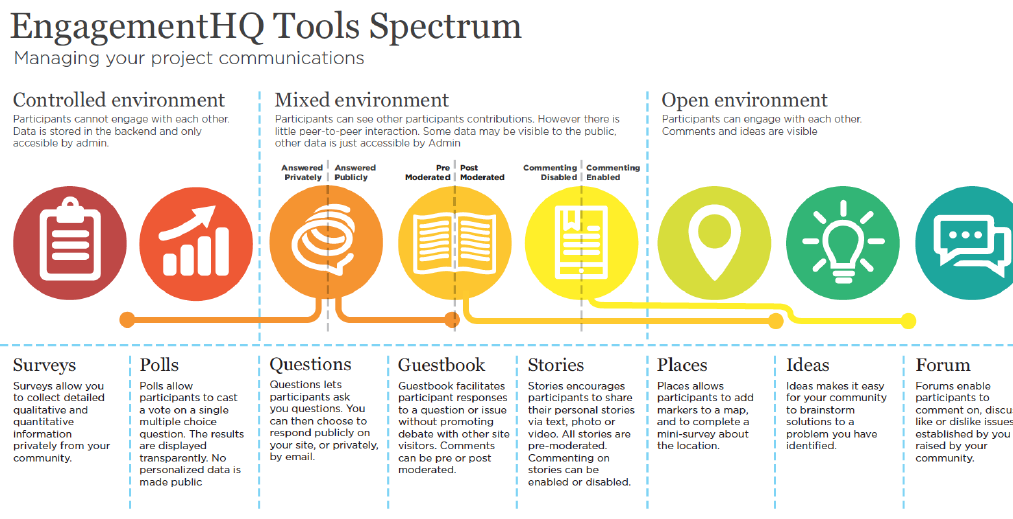
Figure 2. Project communication spectrum [6].